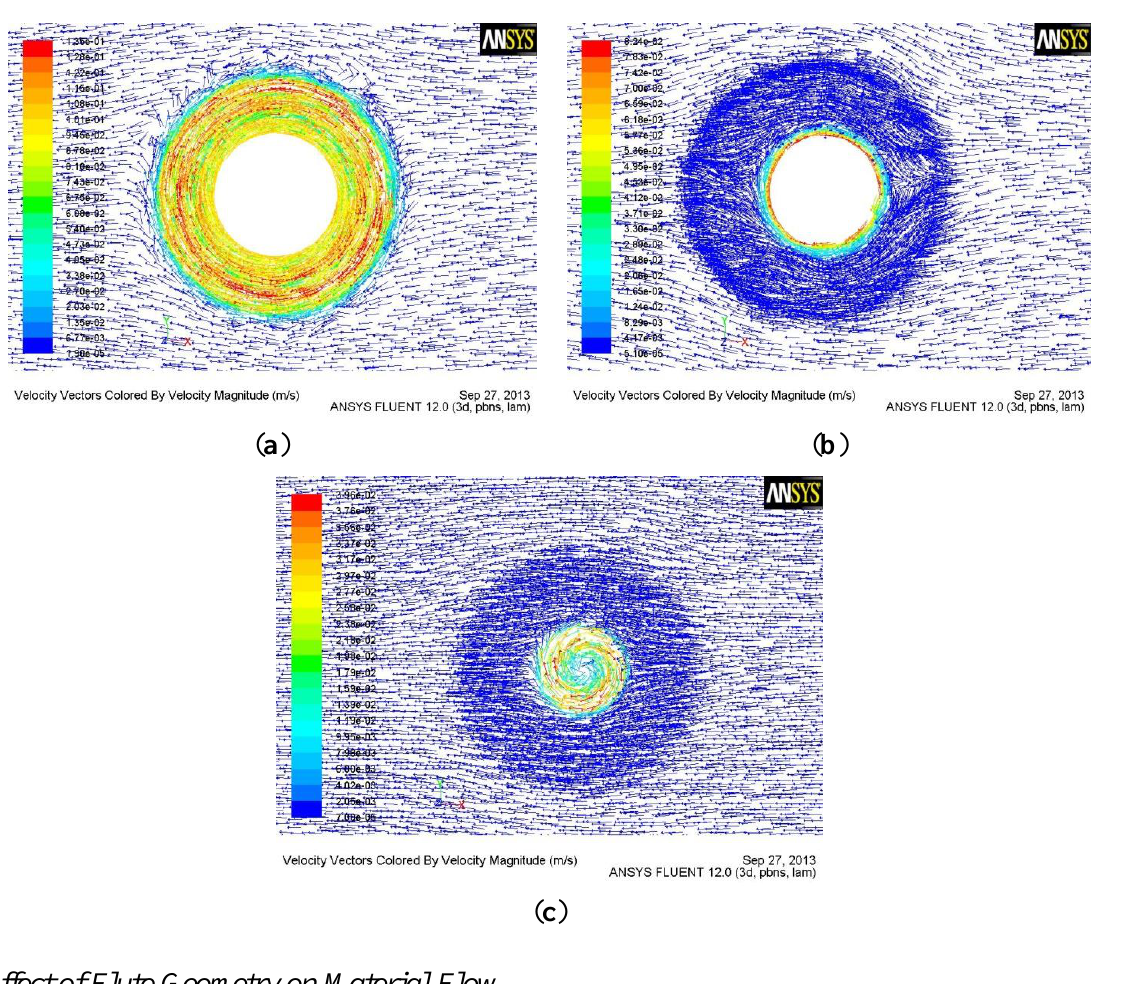
Figure 5. ( a ) Flow field of section a parallel to the workpiece surface; ( b ) Flow field of section b; ( c ) Flow field of section